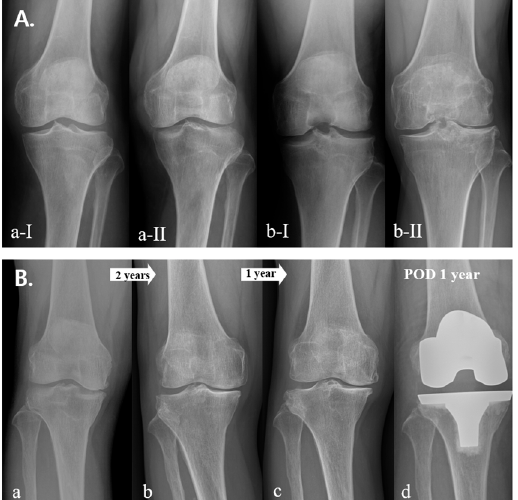
Figure 4. ( A ) Comparison of progression rate of OA according to initial K–L grade, ( a-I ) initial X-